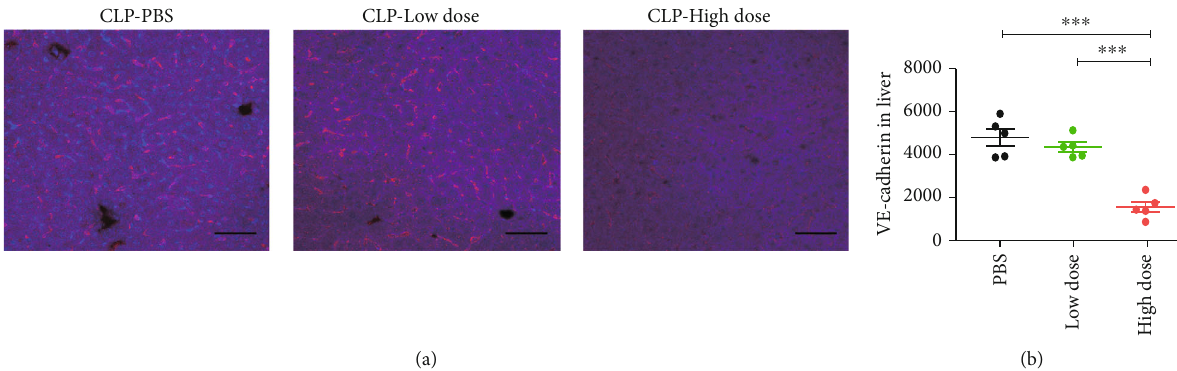
Figure 6: Administration of high dose of HNP-1 destroys liver endothelial cell junctions during sepsis progression. Wild-type mice were intraperitoneally administered a high dose of HNP-1 (10 mg/kg body weight), a low dose of HNP-1 (0.5mg/kg body weight), or PBS 6 hours after CLP. (a) Representative images and (b) comparisons of VE-cadherin abundance in the liver at 48 hours after CLP are shown. The results presented are the means ± SEMs of 5 mice in each group. Scale bars, 50 μ m. ∗∗∗ P < 0 : 001